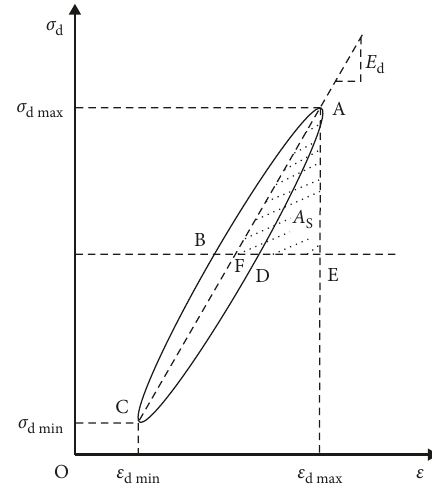
Figure 5: Hysteresis loop of dynamic strain and